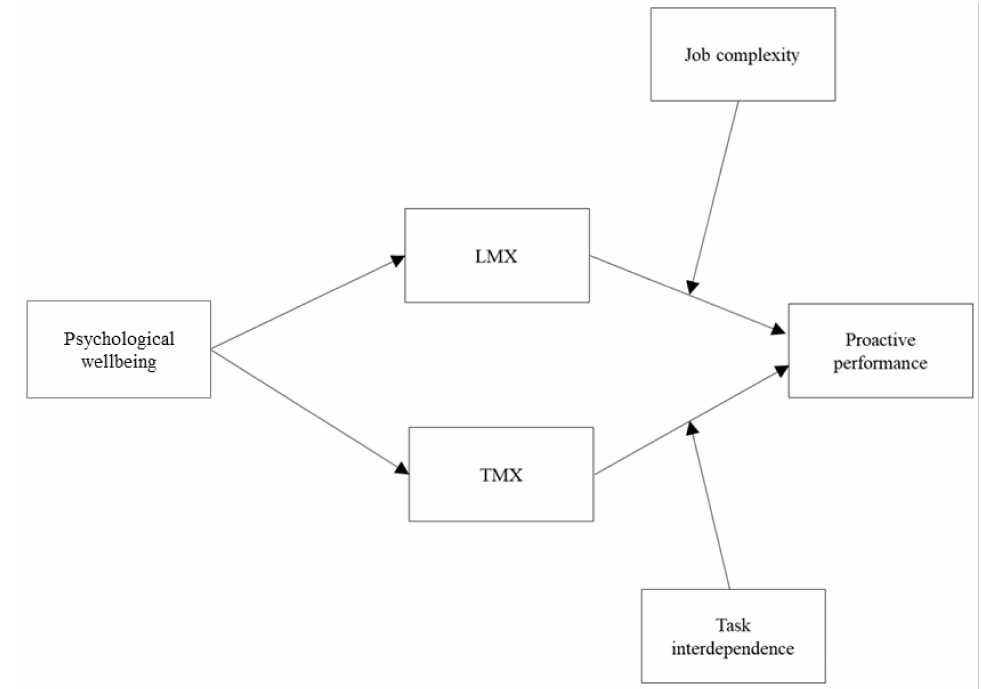
Figure 1. Conceptual model. LMX = leader-member exchange; TMX = team-member